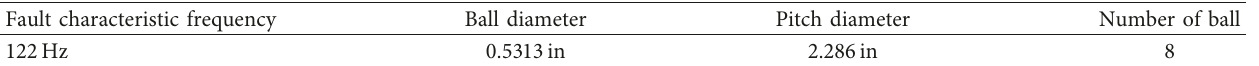
Figure 19: Bearing fault test rig. Table 6: Parameters of the inner ring fault